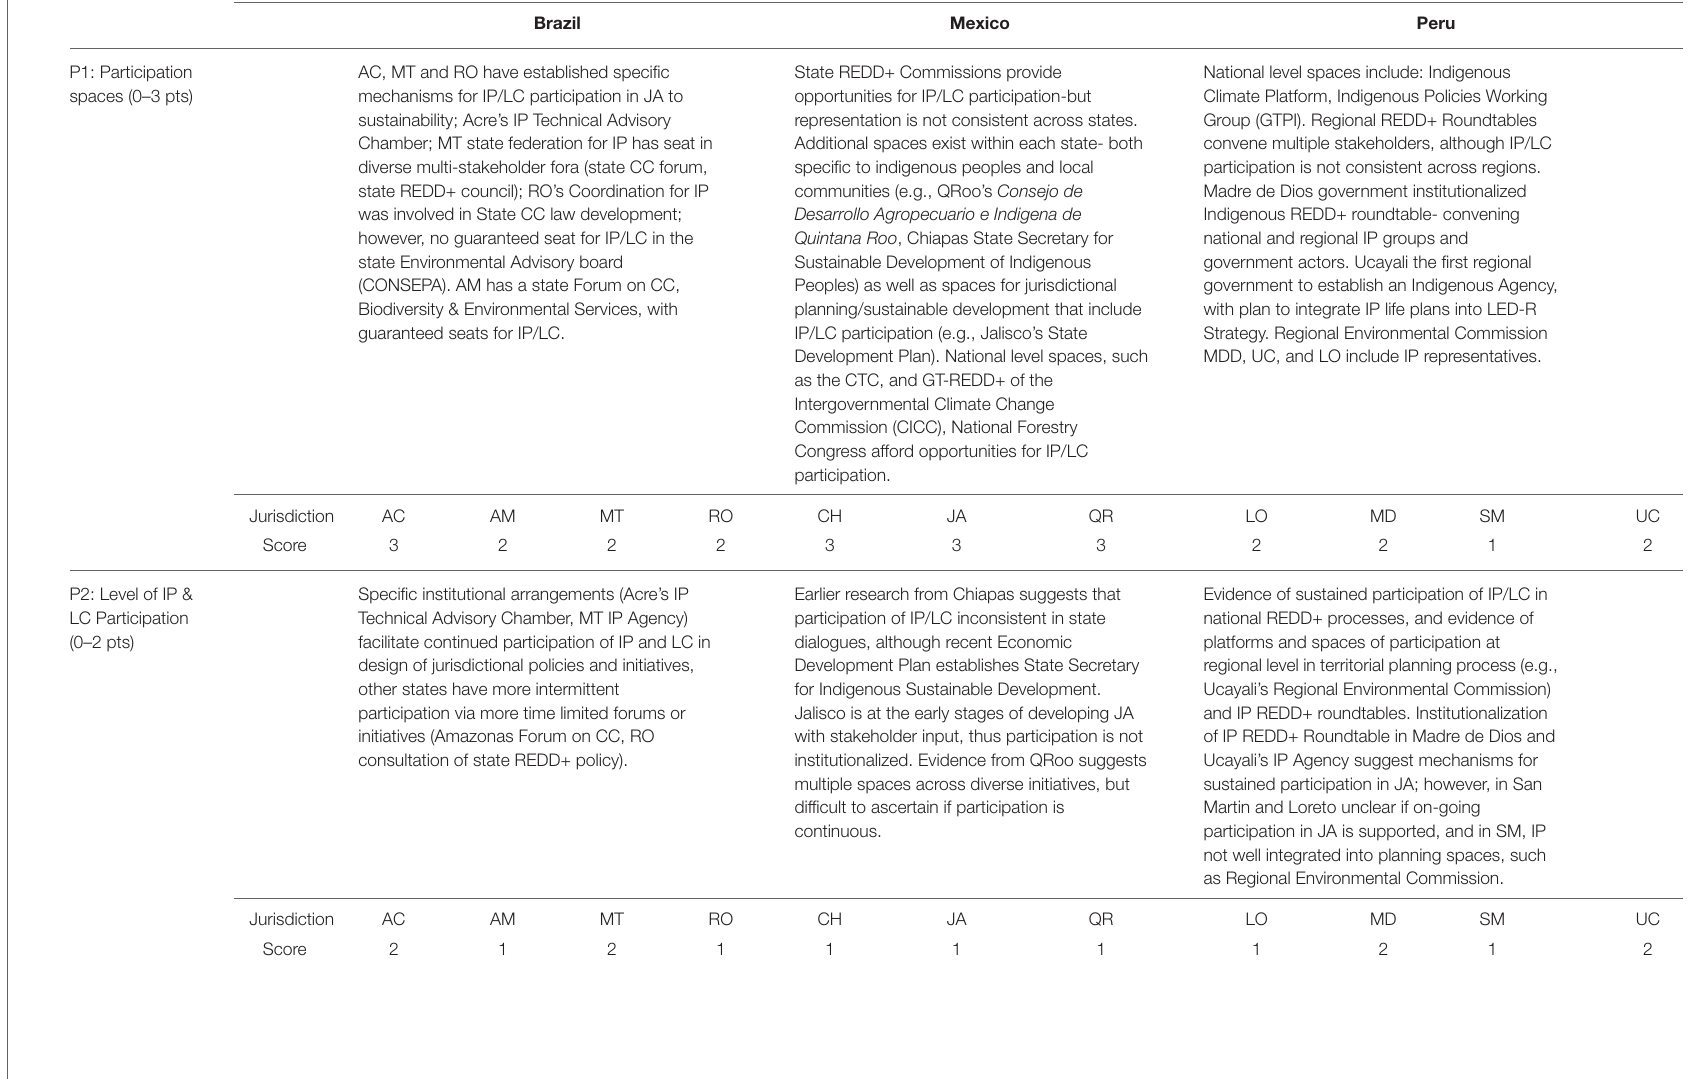
TABLE 5 | Participation.